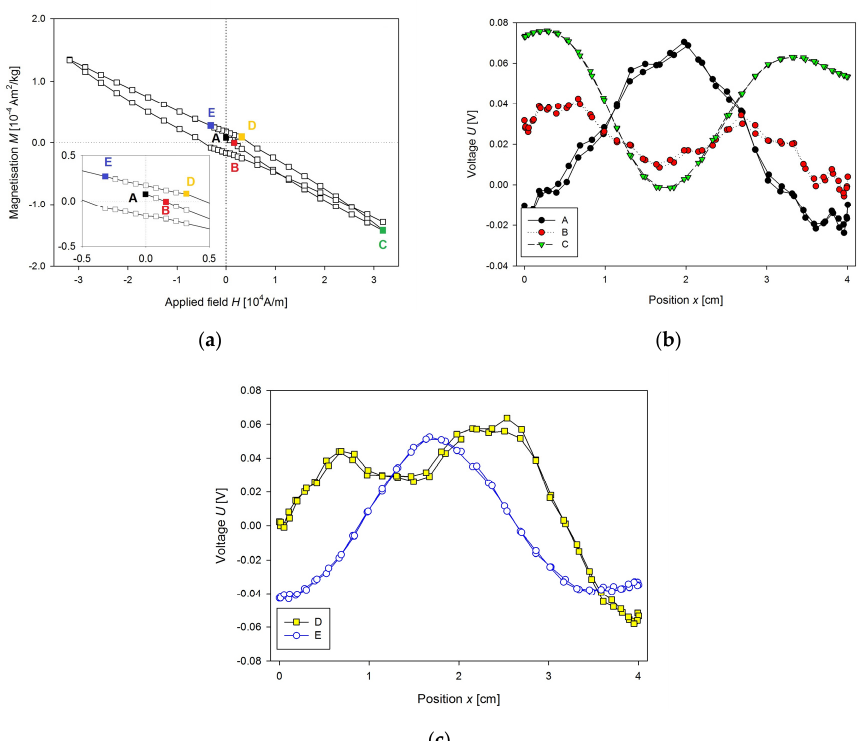
Figure 3. ( a ) M ( H ) dependence of the fresh sample of the liver of Wistar-Kyoto (WKY) rat, ( b ) the voltage output of longitudinal SQUID scan for marked points (A–C) of the M ( H ) dependence presented in Figure 3a, ( c ) the voltage output of the longitudinal SQUID scan for marked points (D–E) of the MH dependence shown in Figure 3a.